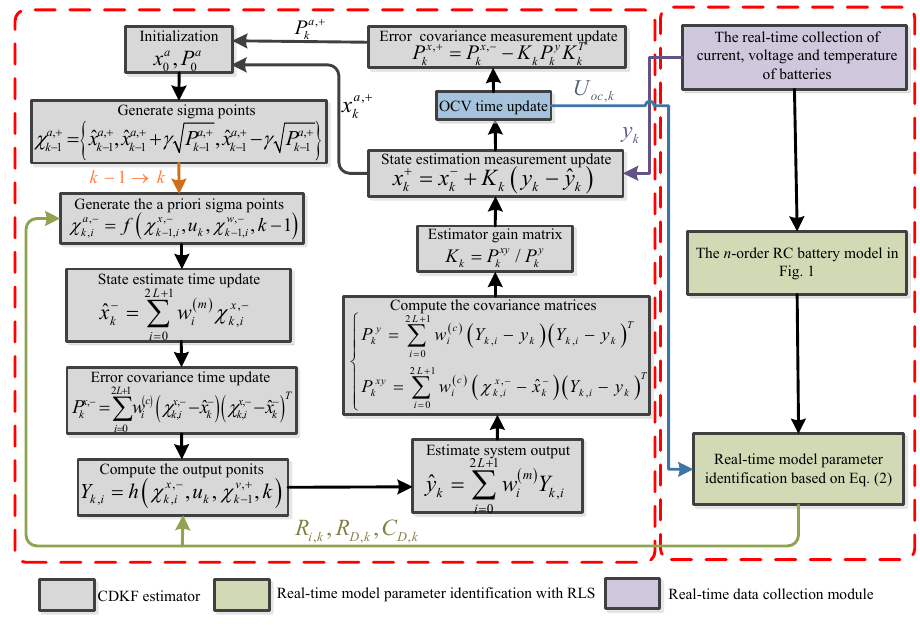
Figure 3. The general diagram of the real-time joint SoC